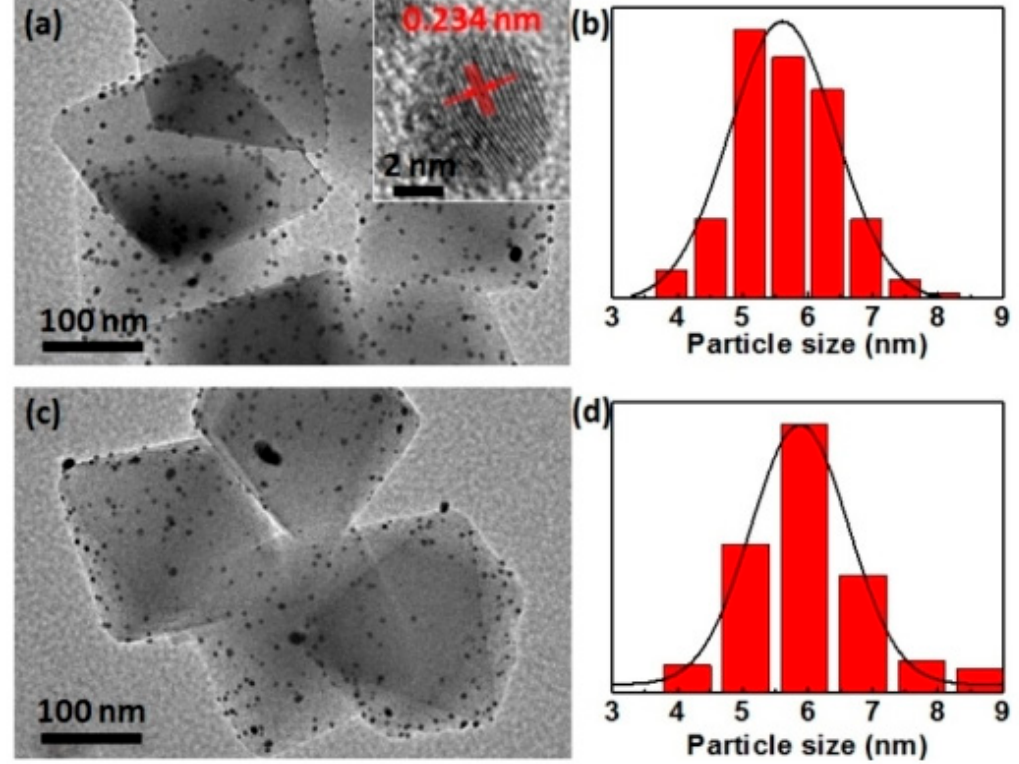
Figure 9. TEM images and corresponding histograms of particle size distribution for as-synthesized Au-Pd 0.03 @UiO-66-NH 2 ( a , b ) and the sample after reaction ( c , d). Reproduced with permission from [60].